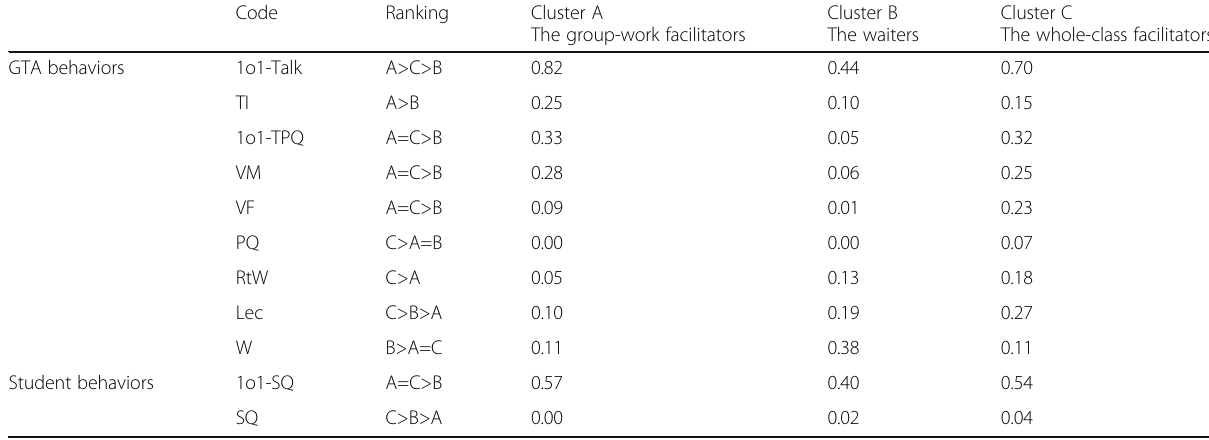
Table 8 Median fractions in each cluster of physics mini-studios. The ranking of clusters for each code is determined by Dunn ’ s test with Holm-Bonferroni corrections